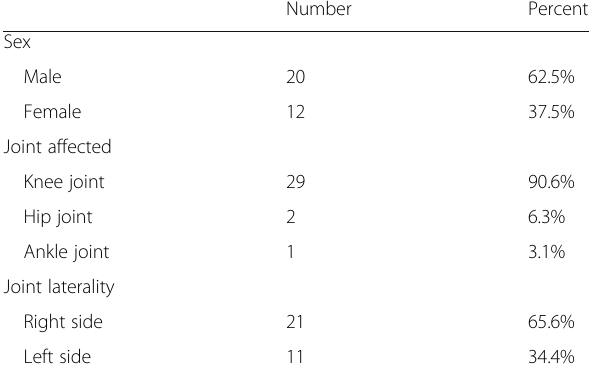
Table 1 distribution of the patients regarding sex, joint affection, and laterality